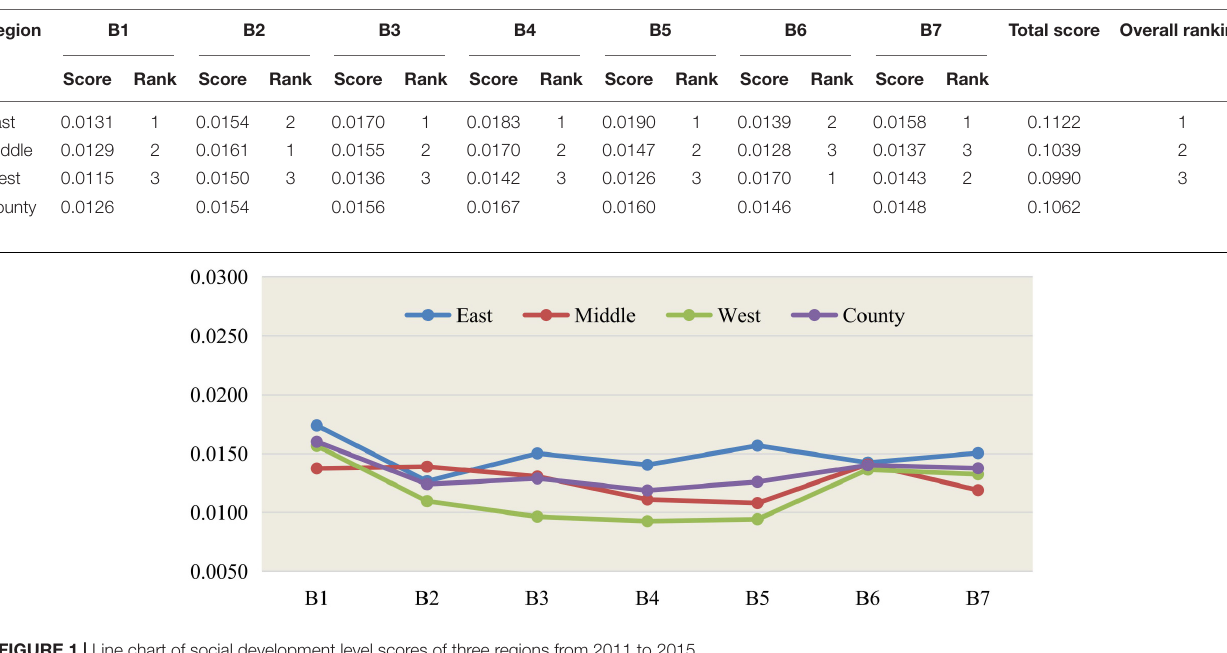
TABLE 3 | 2016–2020 social development level scores of the three regions. Region